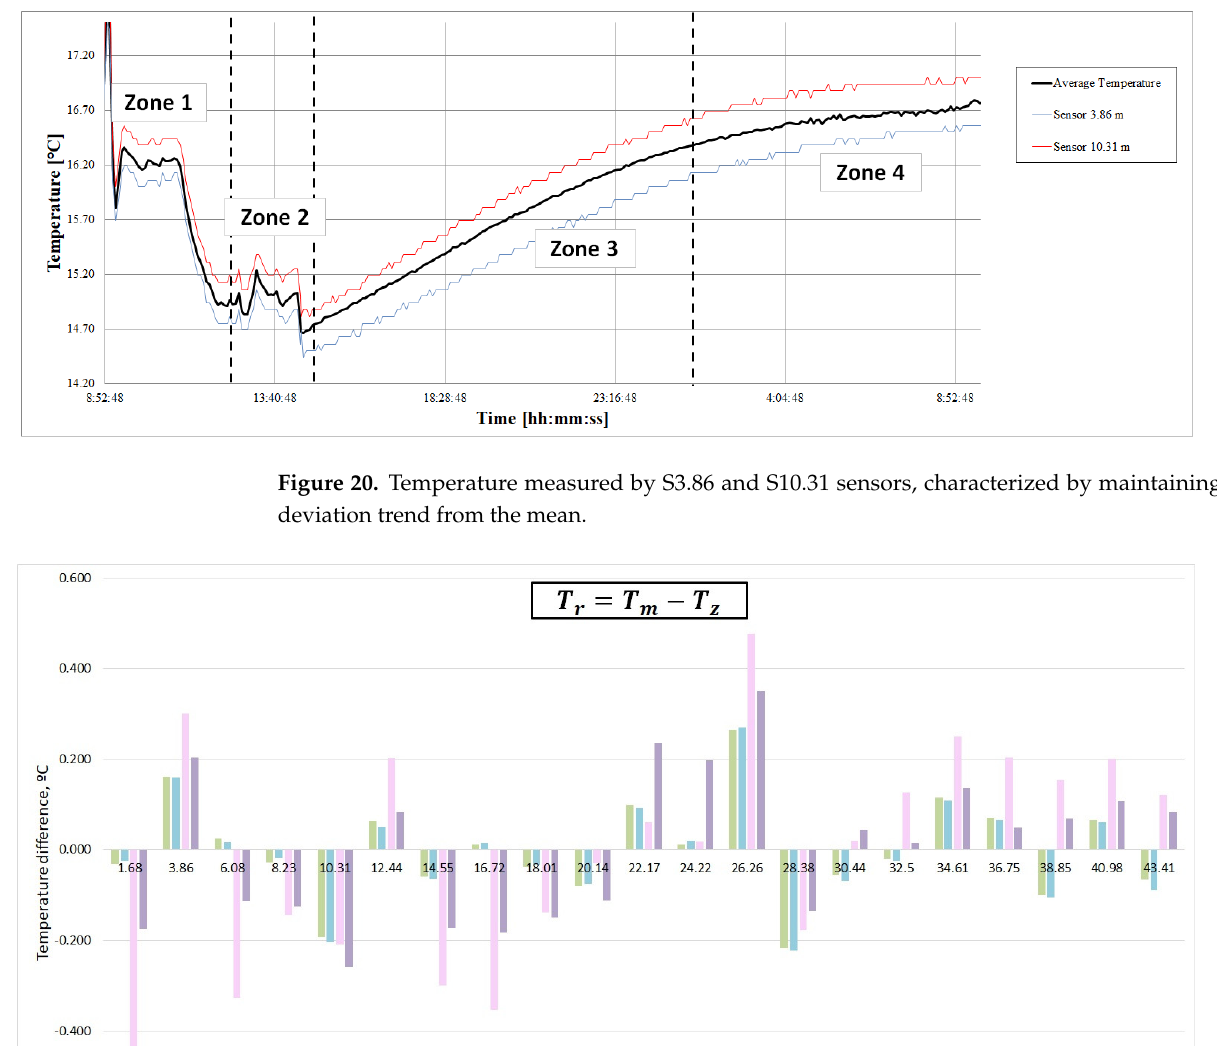
Figure 21. Difference in the mean temperature from each sensor in each zone, according to the mean